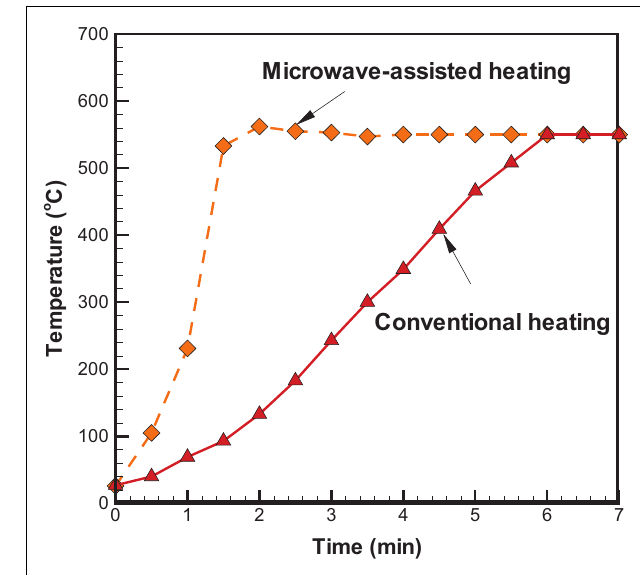
FIGURE 8 |Temporal temperature distributions in the initial period of two different heating modes at 550°C and the absorber blending ratio of 0.1 .